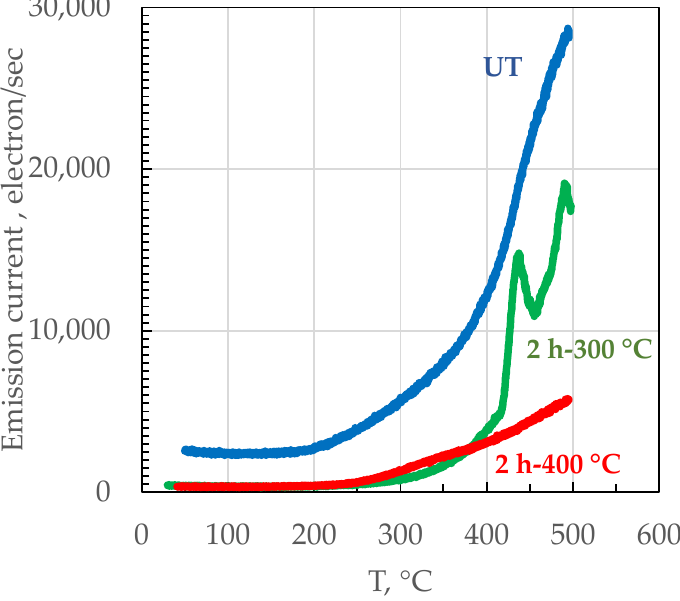
Figure 3. Exo-electron emission (EEE) of the AlSi10Mg LPBF specimens after different post heat treatments as a function of temperature (XZ-specimens).